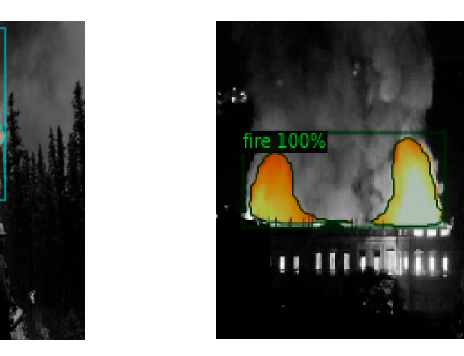
Figure 13. Results of forest fire detection for day images.